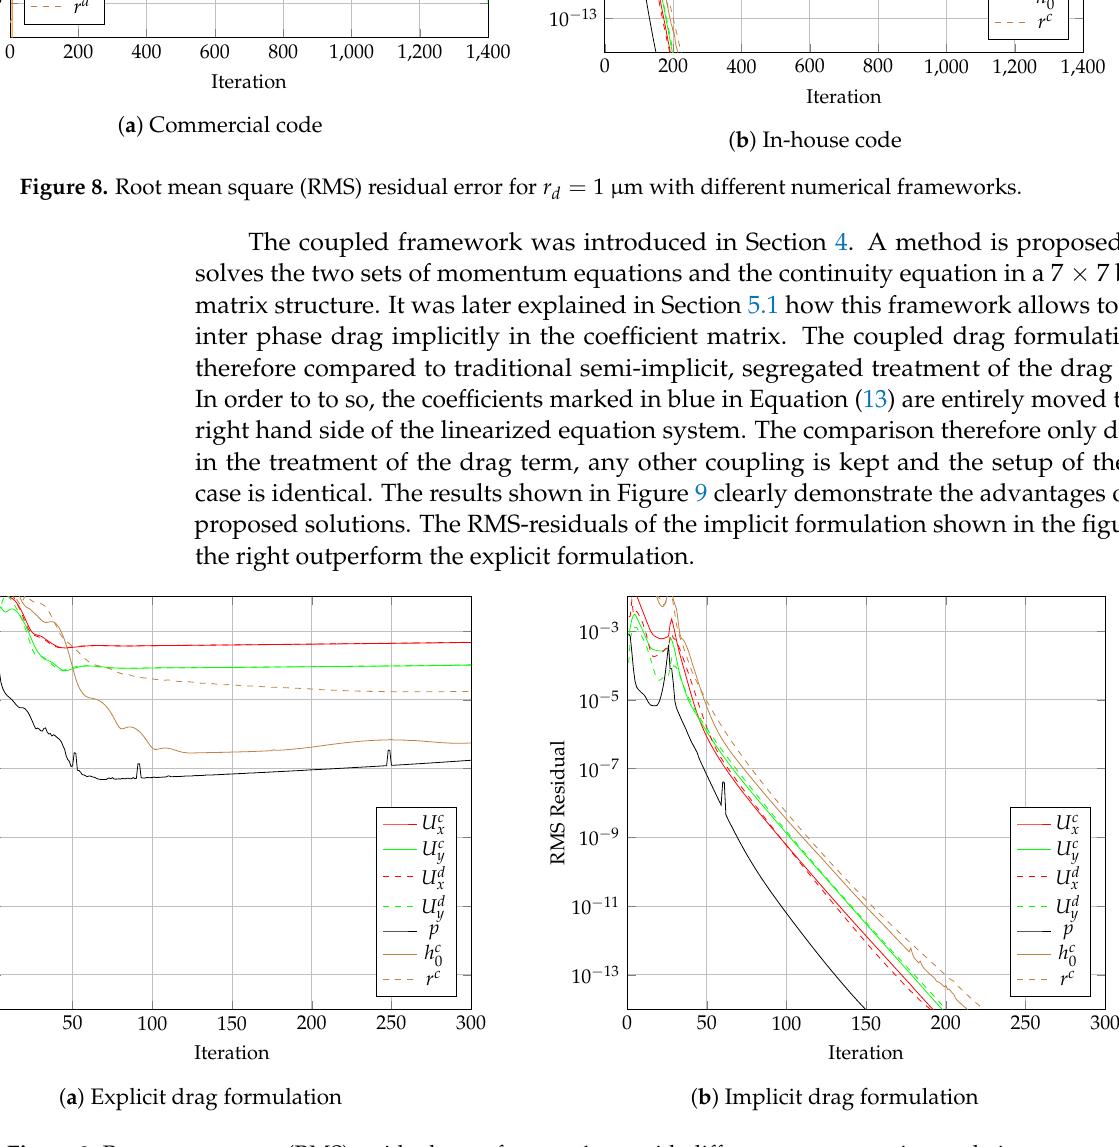
Figure 9. Root mean square (RMS) residual error for r d = 1 µ m with different momentum